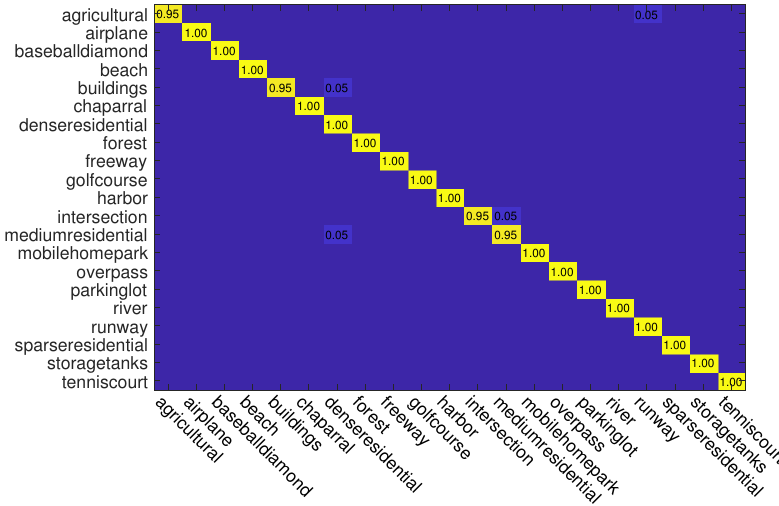
Figure 7. Confusion matrices obtained by ADRL-Net with ResNet50 as backbone on UC Merced dataset. Tr =